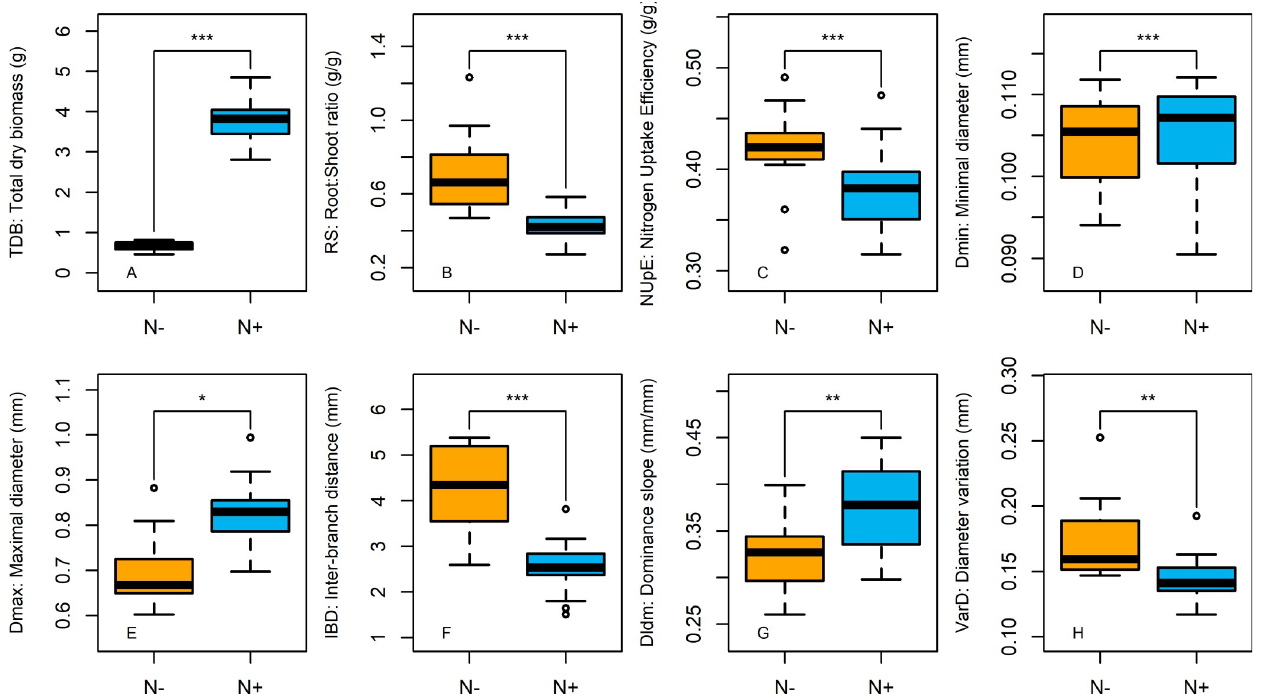
Fig 1. Effect of N availability on 5 RSA traits and 3 PA traits. Boxplots showing the effect of the two nitrogen nutritions on total dry biomass (A), Root: Shoot ratio (B), Nitrogen Uptake Efficiency (C), root minimal diameter (D), root maximal diameter (E), Inter-Branch distance(F), root system dominance (G) and lateral root diameter variation (H). Significant differences between the two N treatments were listed on the top of each graph and were determined through an ANCOVA ( ��� : pvalue < 0.001; �� : pvalue < 0.01; � : pvalue < 0.05; ns: pvalue > 0.05). Orange boxes stand for N- plants and blue boxes stand for N+ plants (n =